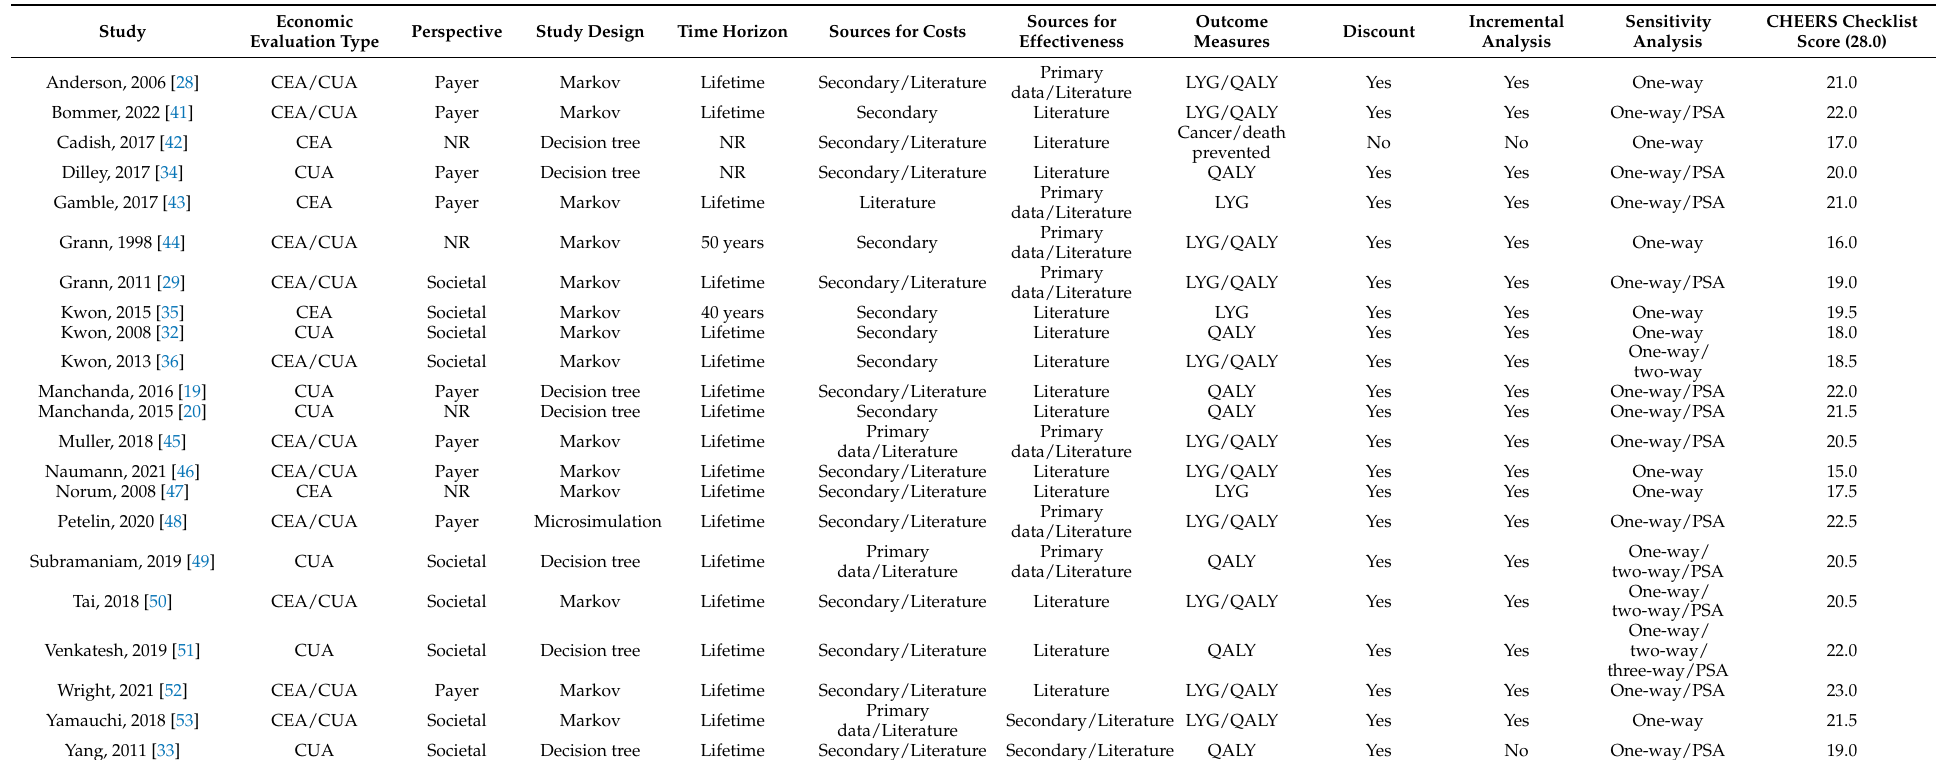
Table 1. Economic evaluation